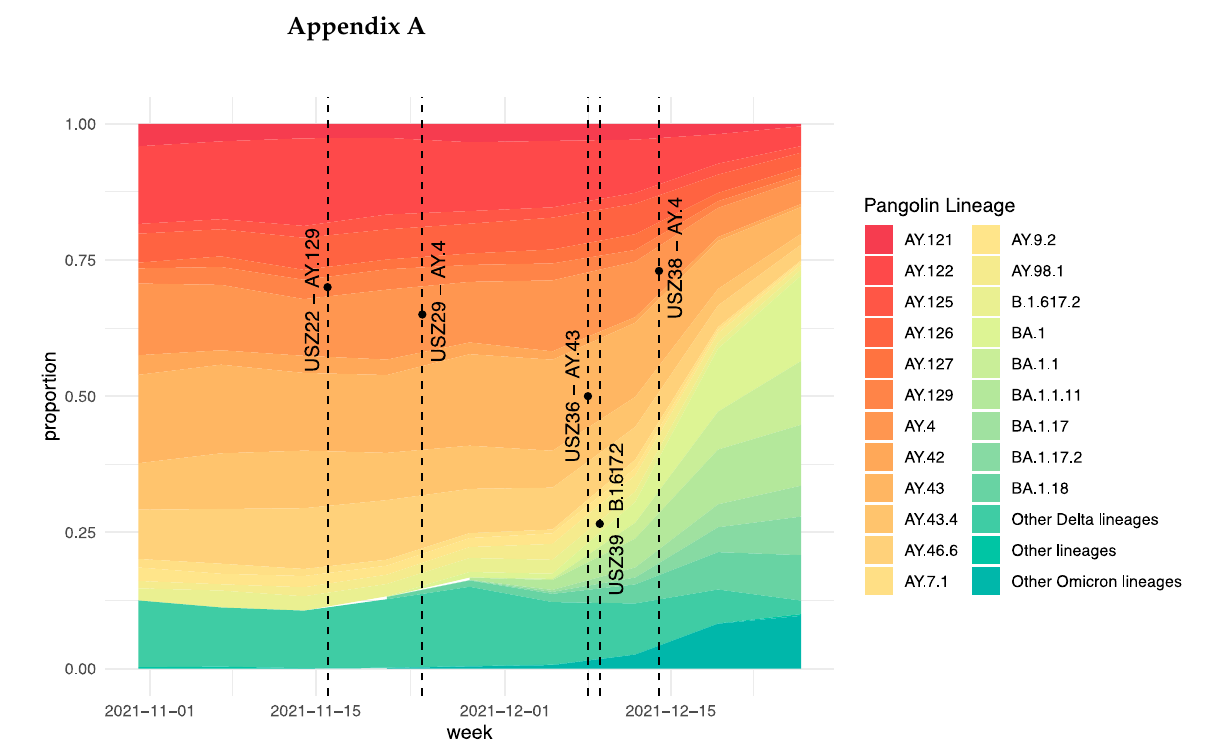
Figure A1. SARS-CoV-2 lineage distribution of Zurich during the sampling period. This plot shows each household and lineage (black dots) of the study and the time of sampling (dashed lines).